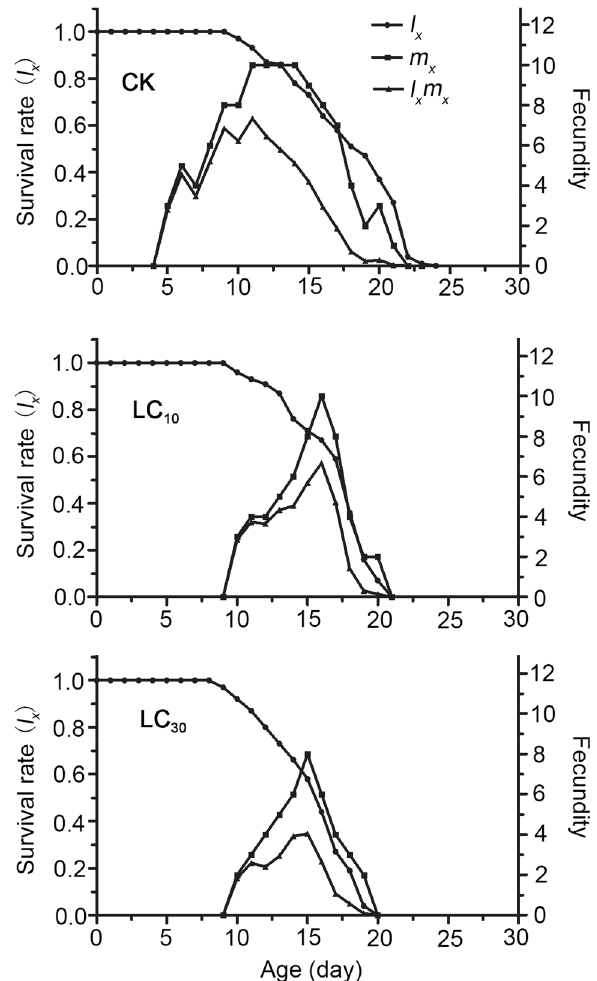
Figure 3. Age-specific survival rate ( l x ), age-specific feundity of the total population ( m x ), and age-specific maternity ( l x m x ) of Panonychus citri . After exposure to low lethal concentrations of